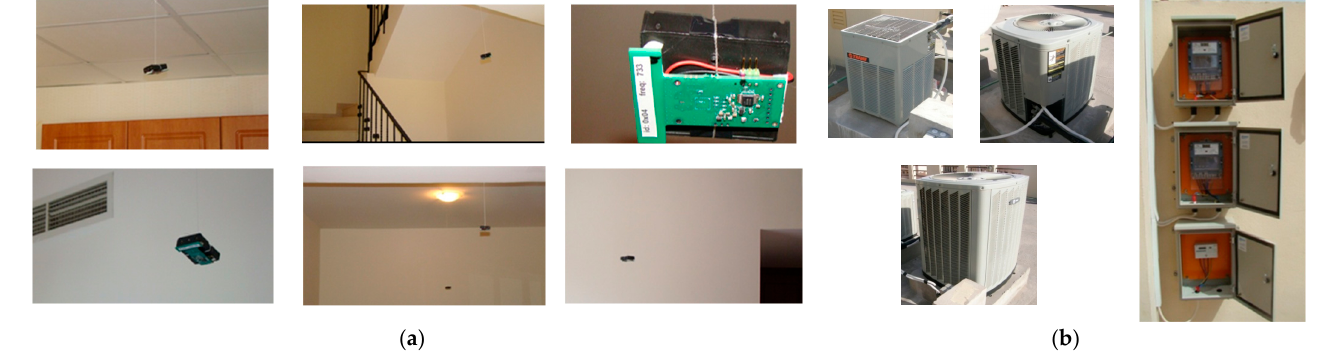
Figure 8. Pictures of temperature sensors, AC equipment, and energy meter devices. ( a ) Tempera- ture sensors installed at various locations. ( b ) AC units and energy meters. sensors installed at various locations. ( b ) AC units and energy meters.